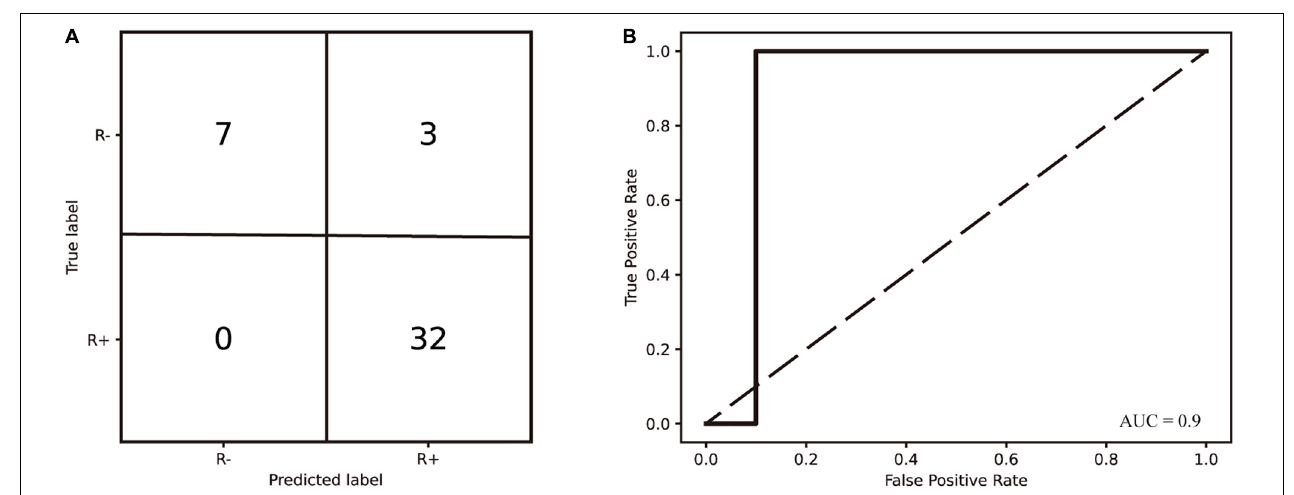
FIGURE 6 | (A) The confusion matrix of diagnosed consciousness classification generated by the SVM (linear kernel). The classifier was trained on the NSC metrics derived from the Resting-EEG. (B) Receiver operating characteristic curves for SVM (linear kernel) prediction models.